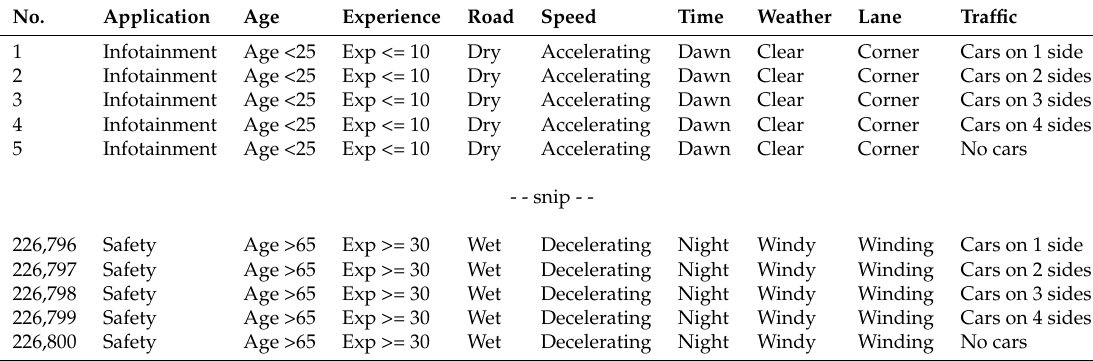
Table 8. VANET dataset.